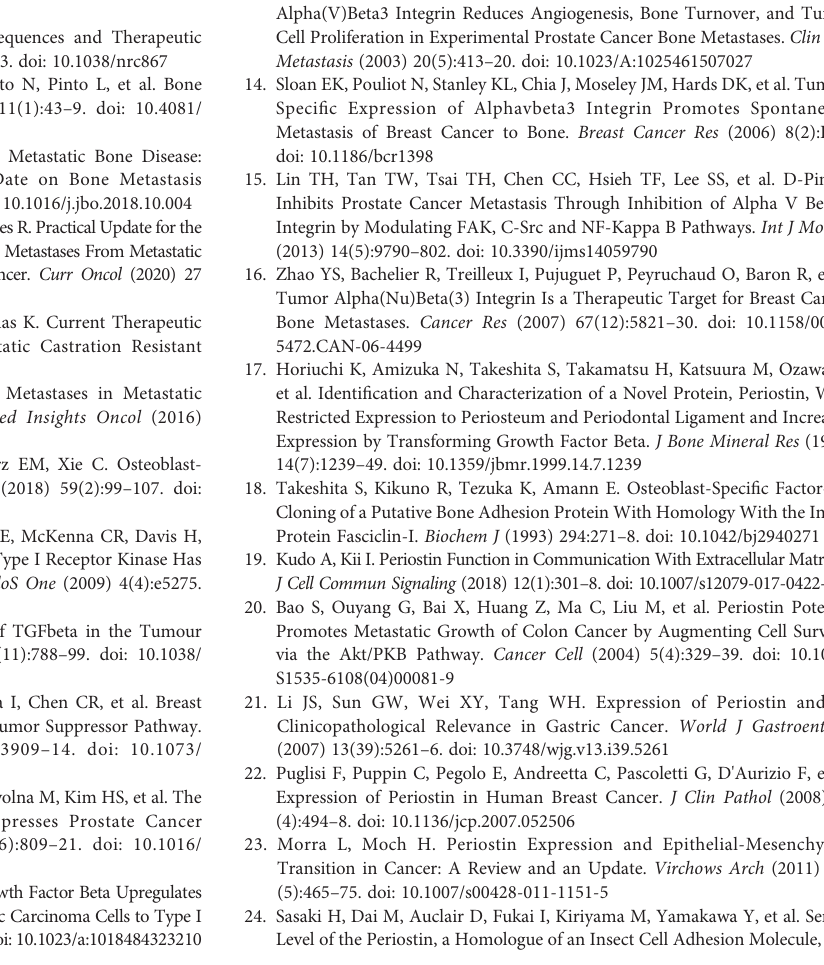
Supplementary Figure 1 | Osteoblasts induce POSTN expression in PC cells via TGF- b . (A) MDA PCa 2b cells were incubated with 30% OBCM and the expression of POSTN was detected by real-time PCR. (B) MDA PCa 2b cells were incubated with 30% OBCM and the expression of POSTN was detected by western blotting. (C) MDA PCa 2b cells were incubated with 30% OBCM and an inhibitor of TGF- b signaling (LY364947). The expression of POSTN was detected by real-time PCR. (D) MDA PCa 2b cells were incubated with 30% OBCM and an inhibitor of TGF- b signaling (LY364947). The expression of POSTN was detected by western blotting. *p < 0.05 compared with control; # p < 0.05 compared with the OBCM or PCCM- treated